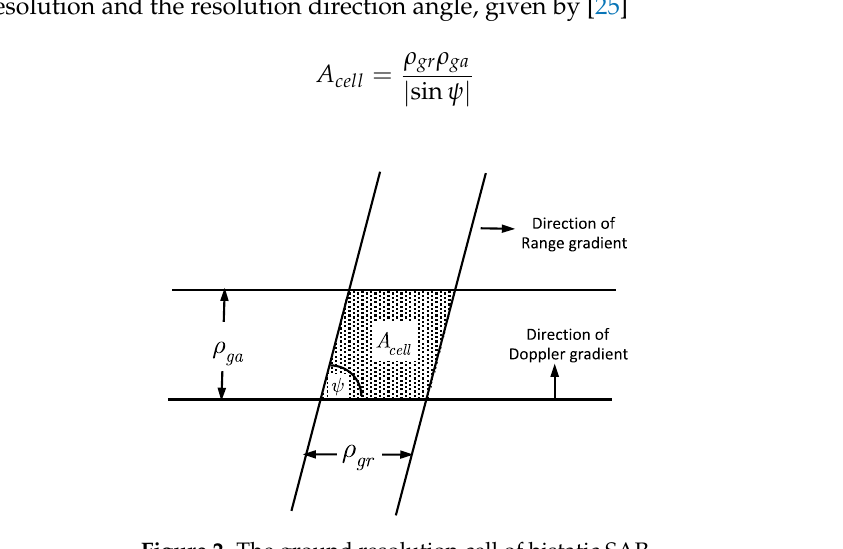
Figure 2. The ground resolution cell of bistatic SAR.